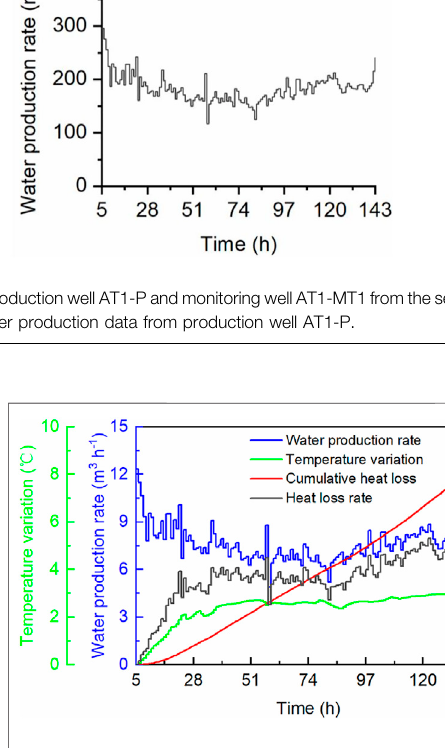
FIGURE3 | Calculation results ofthe heat loss from produced formation water contributing to hydrate dissociation.